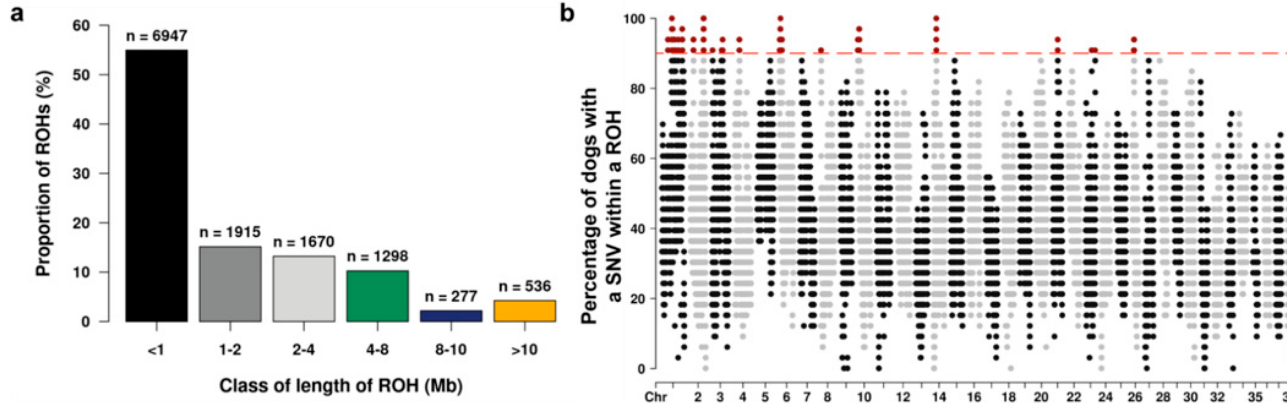
Figure 3. Genome-wide ROH analysis of the Bernese mountain dogs. ( a ) Distribution of six different ROH length classes. ( b ) Incidence plot showing the proportion of the 33 individuals with a specific SNV in a particular ROH across the 38 canine autosomes; red dashed line indicates the 90% cutoff for determination of the ROH islands (in dark red).